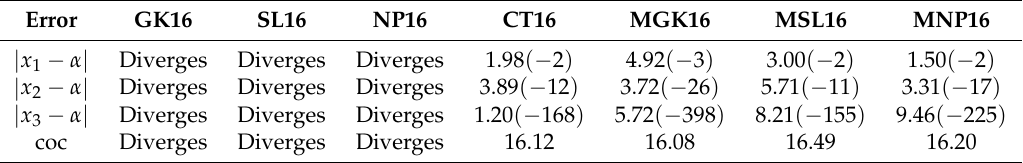
Table 9. Numerical results for f 7 , x 0 =